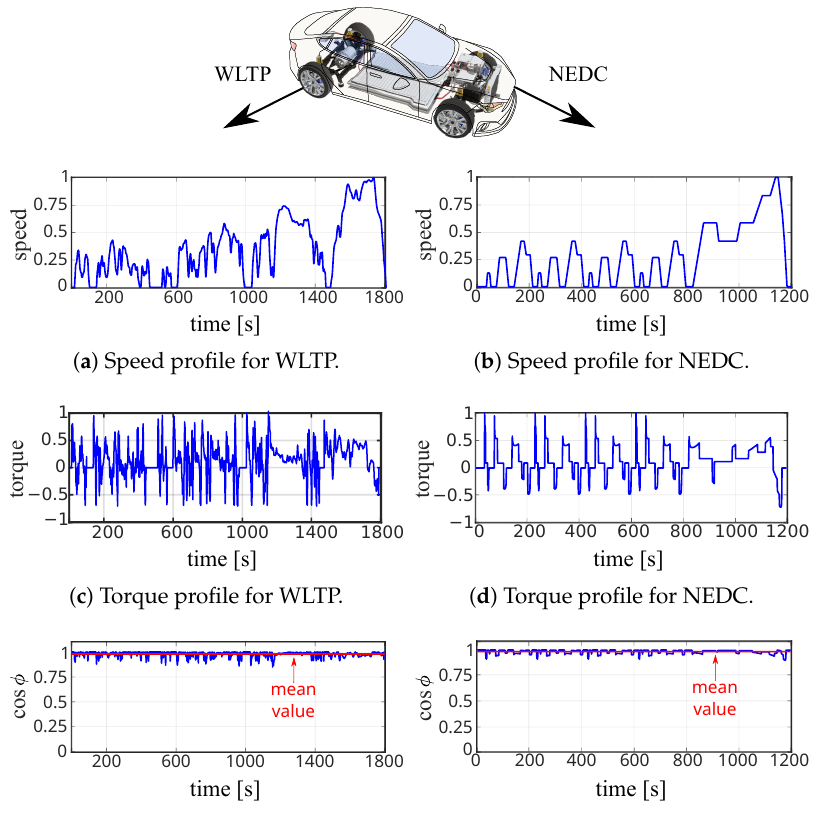
Figure 7. Speed and torque profiles in addition to the cos φ values corresponding to WLTP and NEDC driving